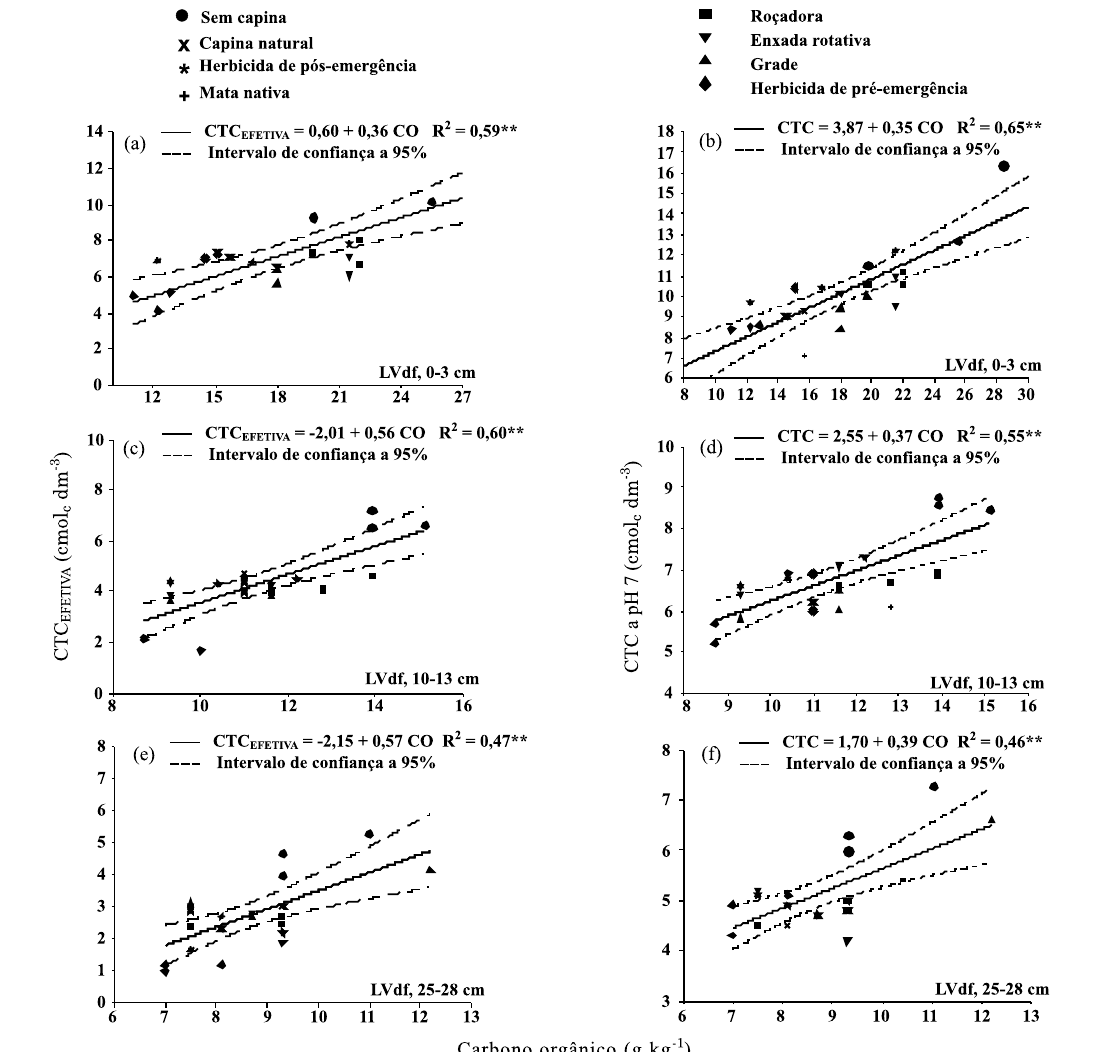
Figura 1. Capacidade de troca de cátions efetiva (a, c, e) e CTC a pH 7 (b, d, f) em função do conteúdo de carbono orgânico de um Latossolo nas profundidades de 0–3, 10–13 e 25–28 cm, submetido a sistemas de manejo de plantas invasoras em uma lavoura